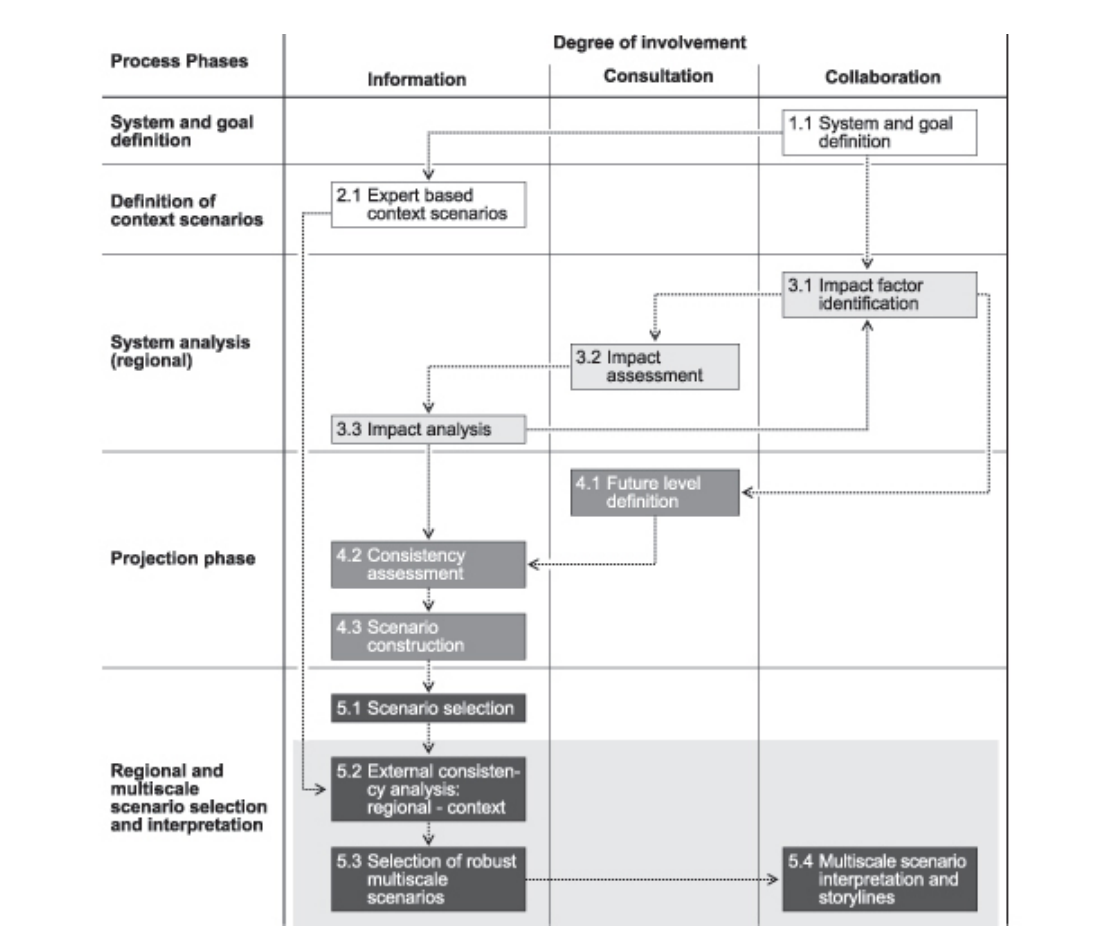
Fig. 4 . The formative scenario analysis and an external consistency analysis in combination with a functional-dynamic approach to theory-practice cooperation (based on Scholz and Tietje 2002, Stauffacher et al. 2008, Spoerri et al. 2009, Krütli et al. 2010, Trutnevyte et al. 2011). The figure illustrates steps 1.1 to 5.4 of our analysis. The arrows indicate possible sequences within a formative scenario analysis (FSA). The arrow that is drawn from “impact analysis” back to “impact factor identification” illustrates that the selection of impact factors can be reassessed by using the impact analysis. The figure has been developed with reference to von Wirth et al.